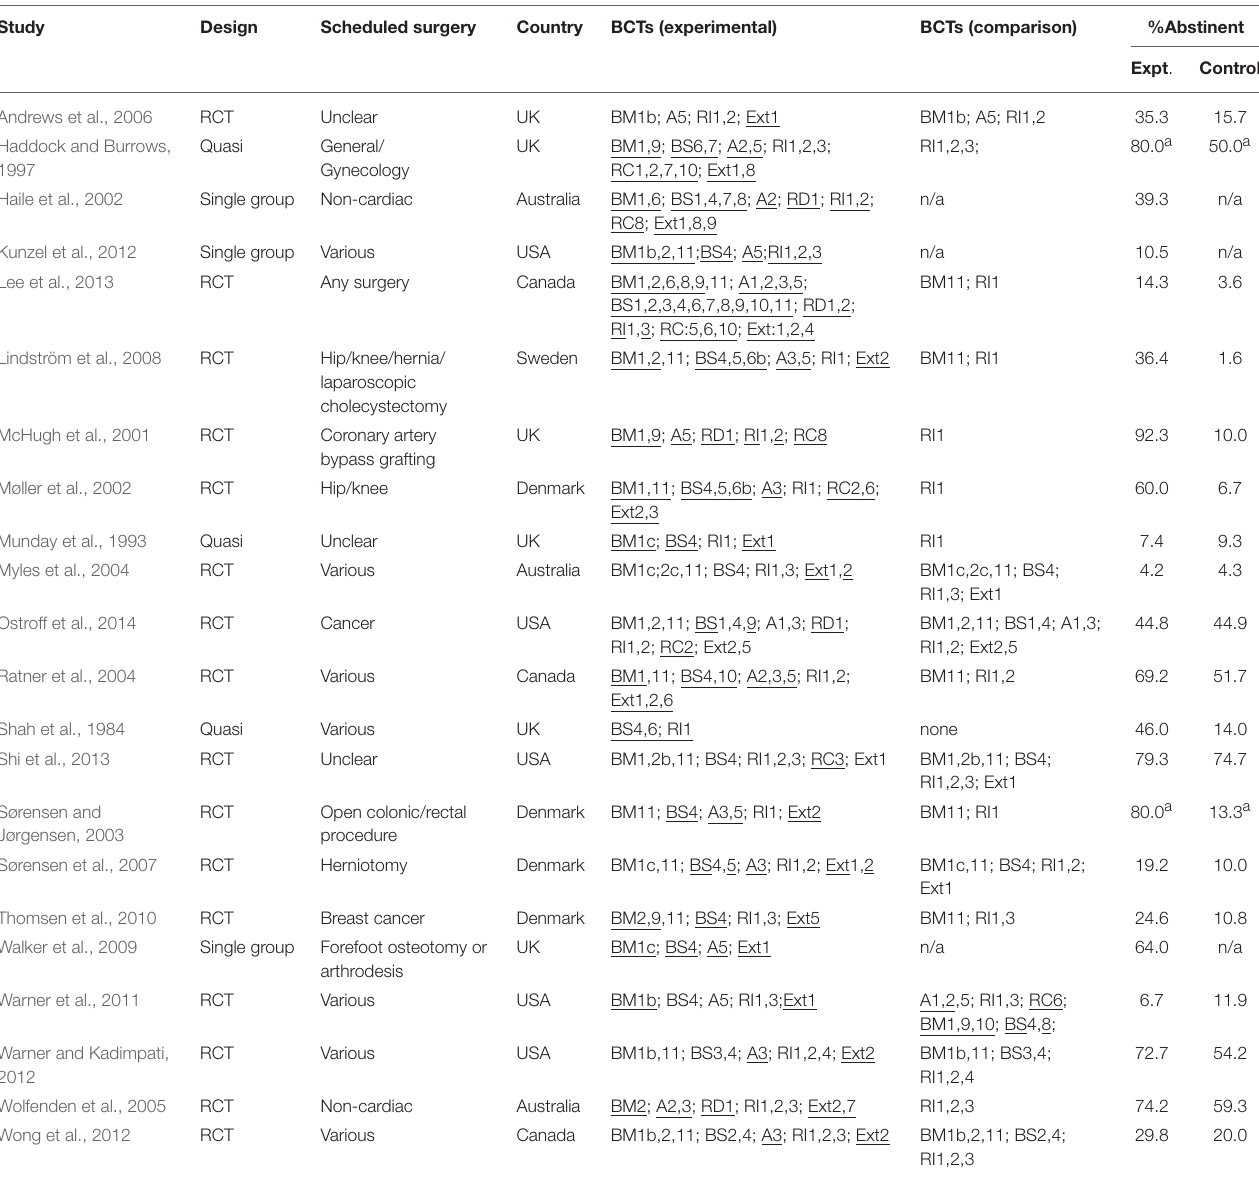
TABLE 2A | Characteristics of included